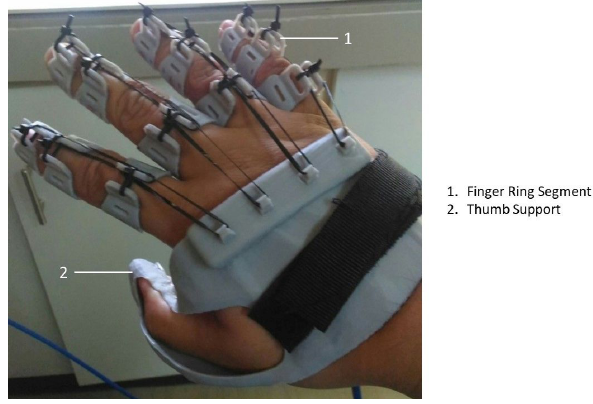
Figure 14: Finger ring segments and thumb support assembly